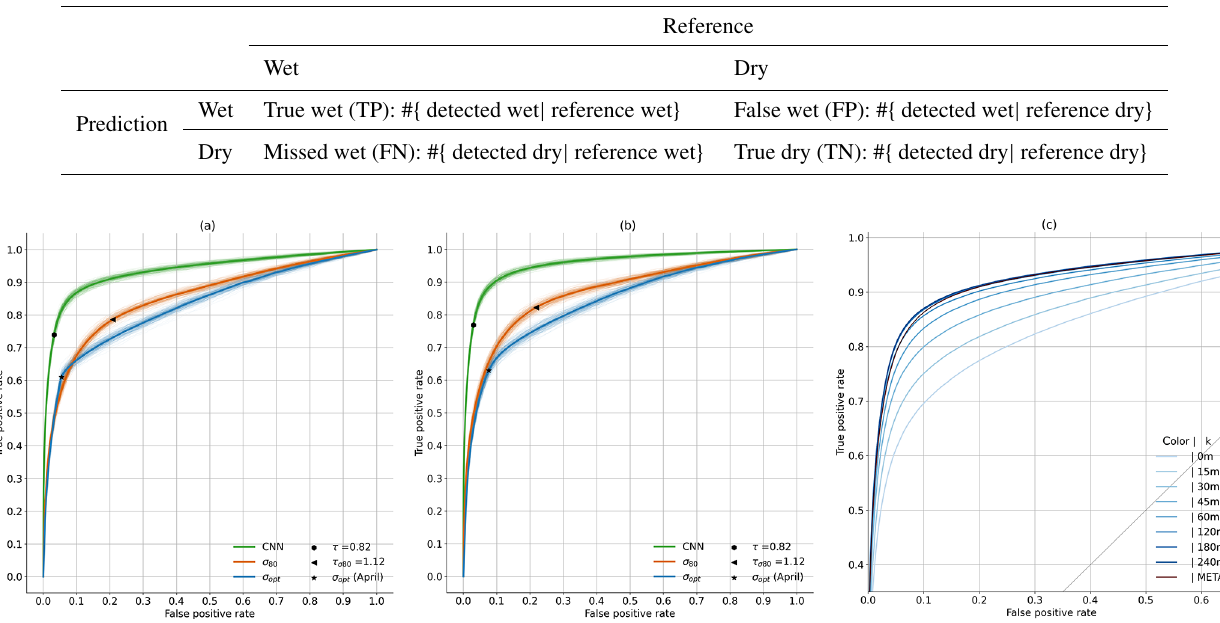
Figure 4. Receiver operating characteristic (ROC) curves on VALAPR (a) and VALSEP (b) . Fine lines are generated by 200 random selections (bootstrapping) of 1% of the samples and account for the variability of the model performance during a random short period ( ∼ 8h) of data. The performances of the CNN for different values of k and the added metadata are shown in (c) , and the AUC values are given in Table